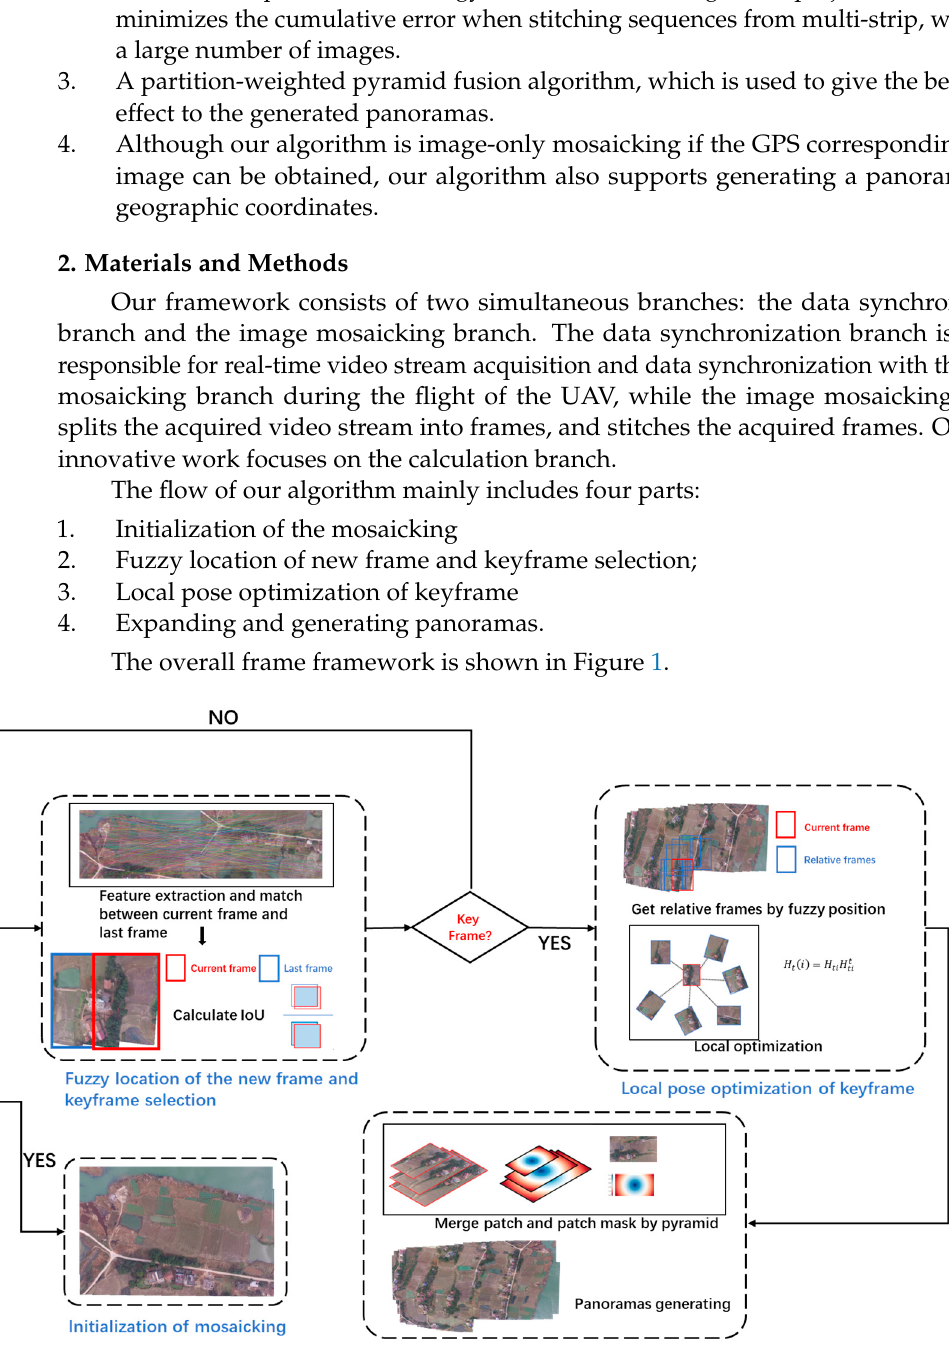
Figure 1. The overall framework. The framework mainly includes four tasks: (1) initialization of mosaicking, (2) fuzzy location of the new frame and keyframe selection, (3) local pose optimization of keyframe, (4) expanding and generating panoramas.